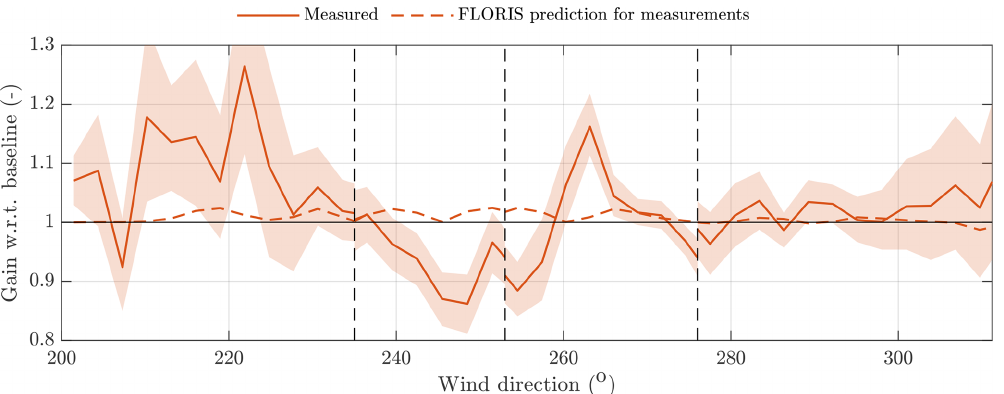
Figure 11. The estimated net gain of the three turbines for wake steering compared to baseline operation. The shaded area shows the 95% confidence bounds. The number of samples in each bin is shown in Fig.